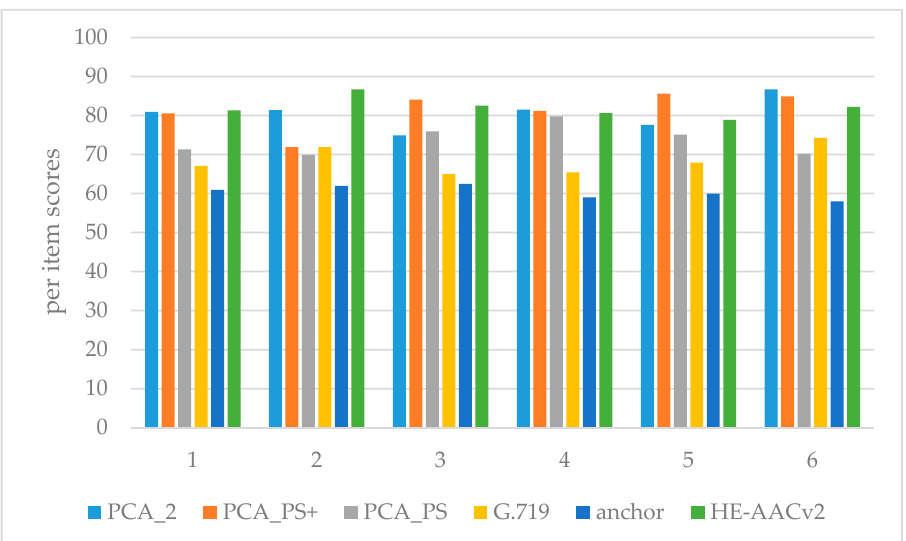
Figure 19. MUSHRA score of per item test. (PCA_2 represents the PCA-based codec signal that is transmitted over two channels separately (75 kbps), PCA_PS+ represents PCA-based codec signal with improved parametric stereo (55 kbps), PCA_PS represents PCA-based codec signal with traditional parametric stereo (56 kbps), G.719 represents G.719 codec signal with traditional parametric stereo (56 kbps), anchor represents anchor signal; HE-AACv2 represents HE-AACv2 signal (55 kbps), and hidden reference material has been removed. 1–6 represents different test materials).